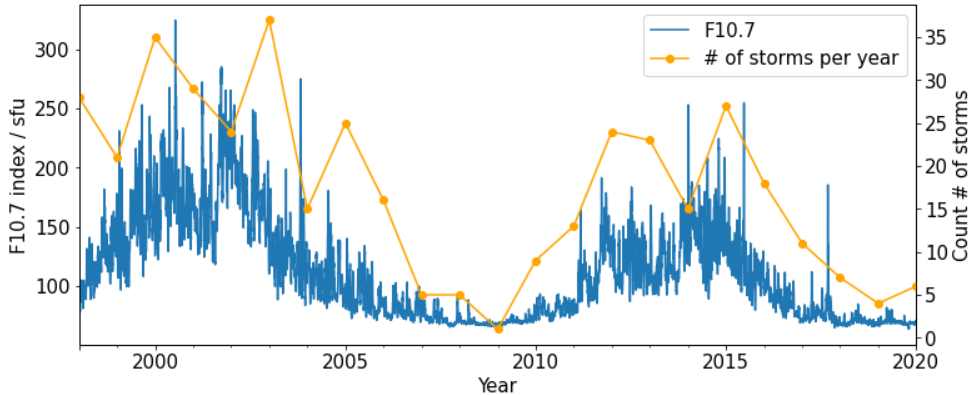
Figure 3. F10.7 solar flux index plotted together with the number (#) of storms counted for each year for the complete dataset which contains storms occurring in the time period from 1998 until 2020.